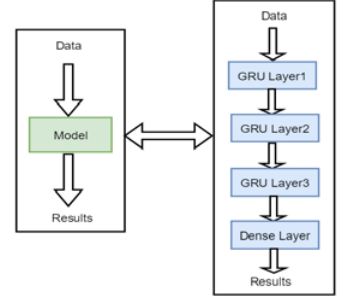
Fig. 2. Deep learning model.